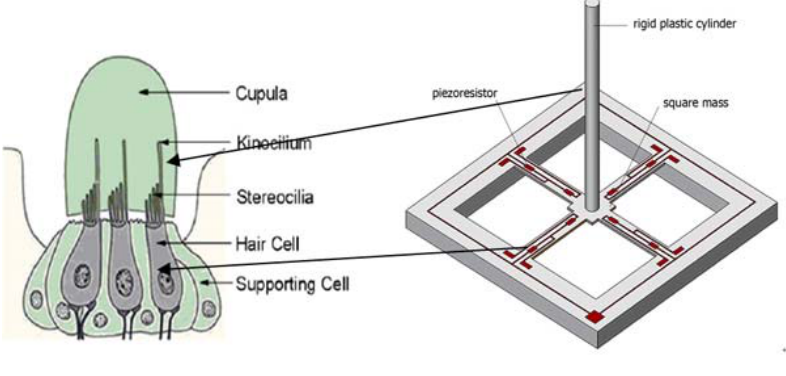
Figure 2. Schematic view of the bionic structure of the MEMS hydrophone.